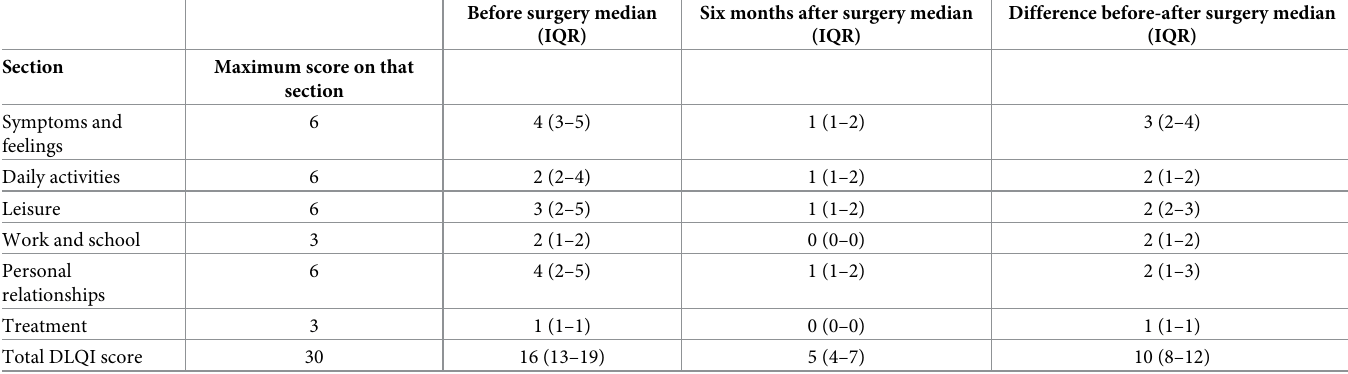
Table 3. Scores on sections of the Dermatology Life Quality Index before and six months after surgery for podoconiosis patientin Bahir Dar, Ethiopia between Janu- ary 2015 and December 2019.